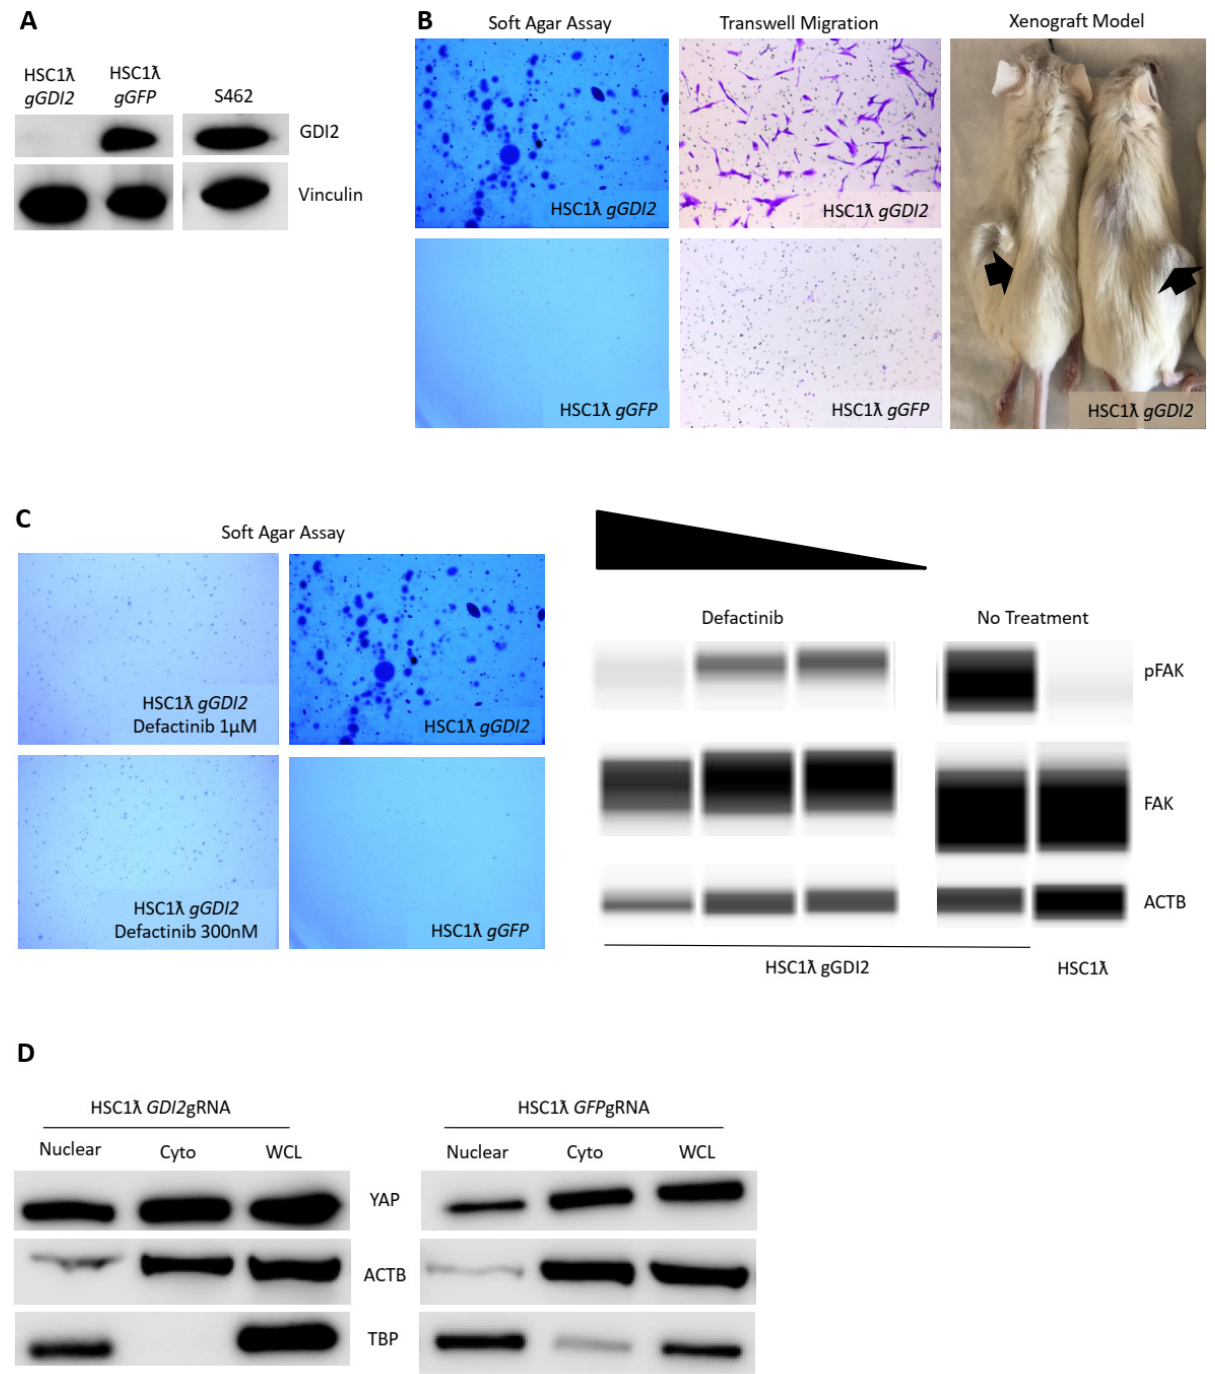
Figure 3. Rho is a MPNST pathway and its negative regulator GDI2 is a novel Schwann cell tumor suppressor gene. ( A ) Western blot showing knockout of GDI2 in an immortalized Schwann cell line and levels in S462 MPNST cells. ( B ) Loss of GDI2 results in transformation as seen by increased anchorage-independent growth cell migration and tumor formation in NRGs (2× magnification). ( C ) Loss of GDI2 results in FAK activation and treatment with defactinib, a Rho inhibitor results in decreased anchorage-independent growth (2× magnification). Digital Western blot (Wess by Protein Simple) shows decreased FAK phosphorylation in GDI2-deficient cells upon treatment with defactinib. ( D ) Loss of GDI2 results in increased YAP levels and nuclear localization.